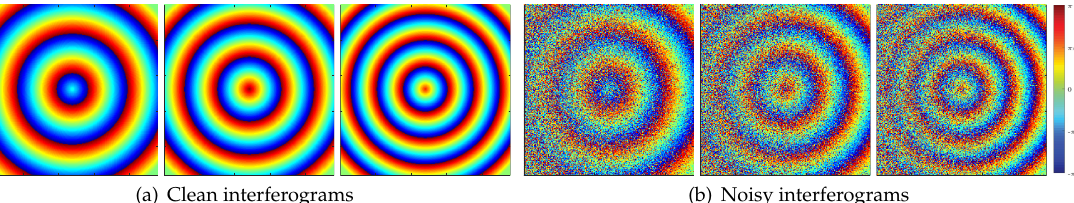
Figure 9. Clean interferograms and noisy interferograms generated by a cone with coherence ranging from 0.1 to